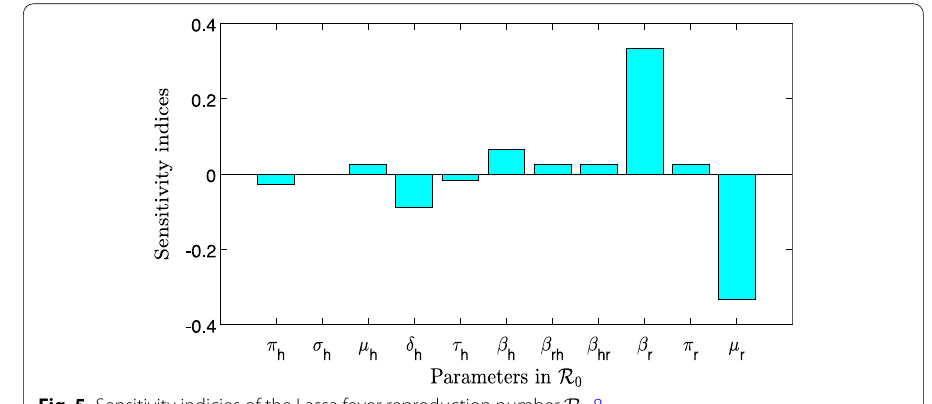
Fig. 5 Sensitivity indicies of the Lassa fever reproduction number R 0 8